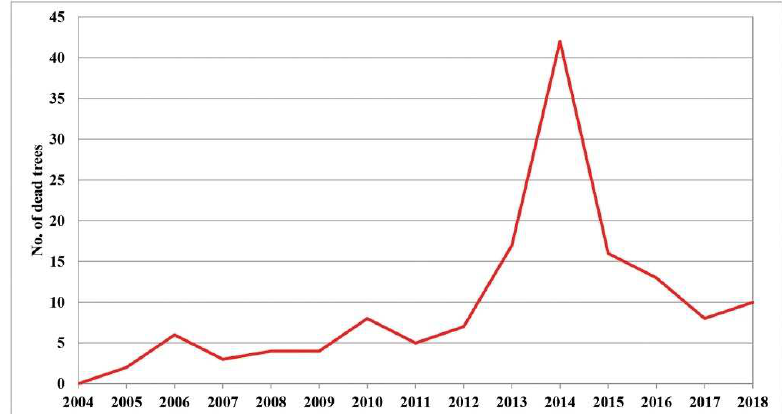
Figure 1. Tree mortality in the Republic of Serbia (2004-2018) (data not shown). Looking at localities with a large number of dead trees, it is evident that trees died either in the same year or in two consecutive years (Table S1). We registered the damage that may be related to climatic conditions where it deviated from the normal values in many parameters. Special attention was paid to damage from unknown causes,